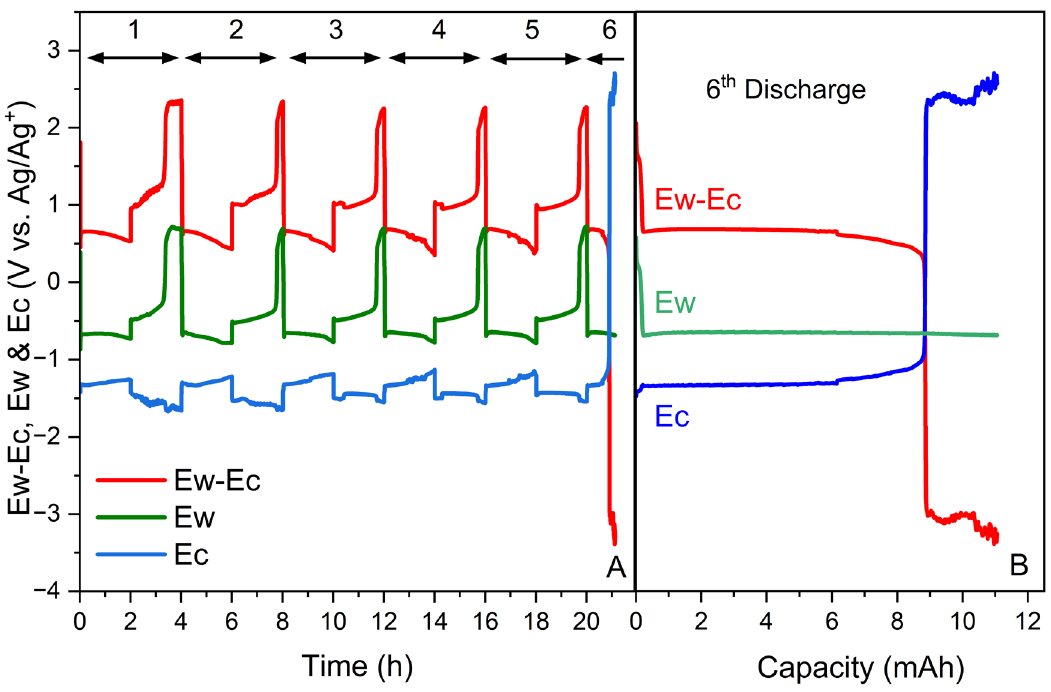
Figure 5. ( A ) Galvanostatic Discharge/Charge vs. time of a Zn/8 M KOH (~1 mL)/Bi 2 O 3 battery, displaying Ew–Ec, Ew, and Ec curves. ( B ) 6th Discharge of this battery vs. capacity, including the three potential curves.